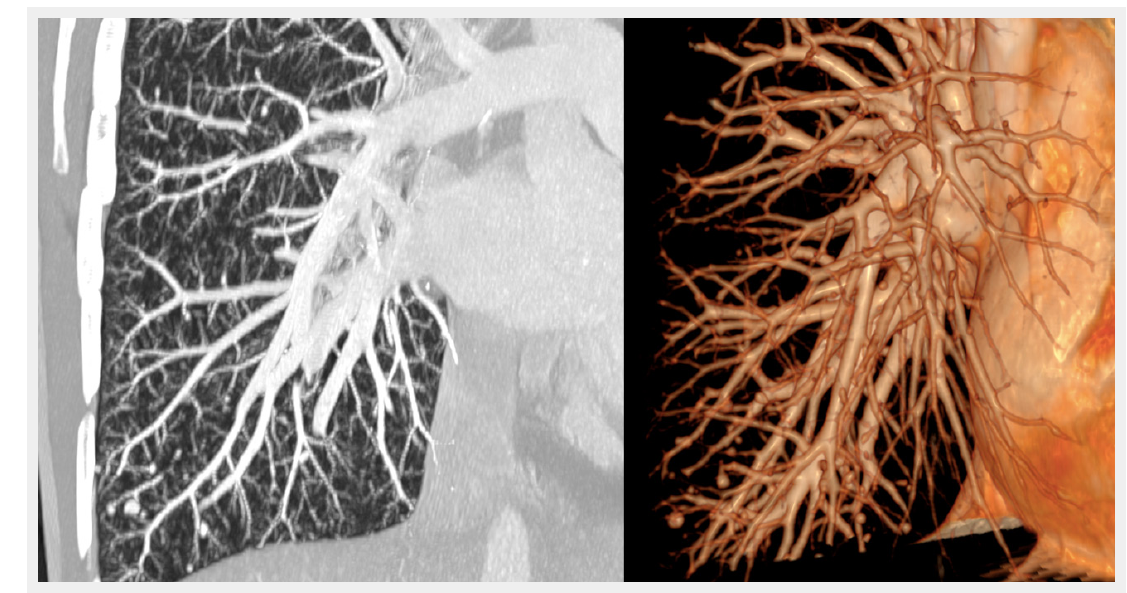
Maximun intensity imaging and 3D reconstructions of pulmonary computed tomography angiography showing numerous pulmonary arteriovenous malformations in a female 50 years old female patient known to have hereditary haemorrhagic